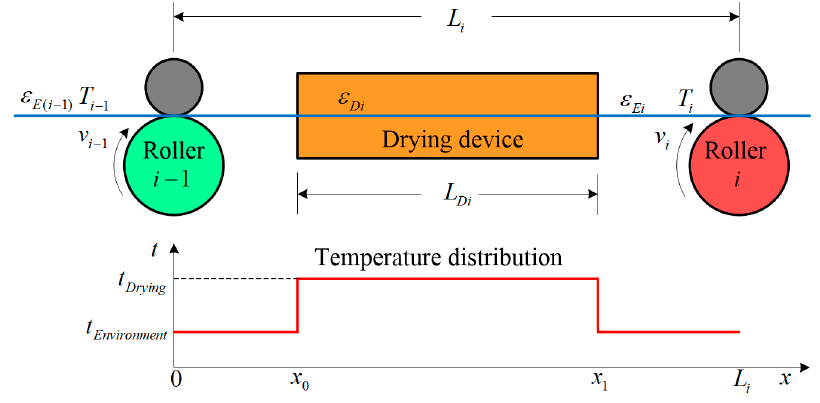
Figure 2. Schematic diagram of the printing subsystem.